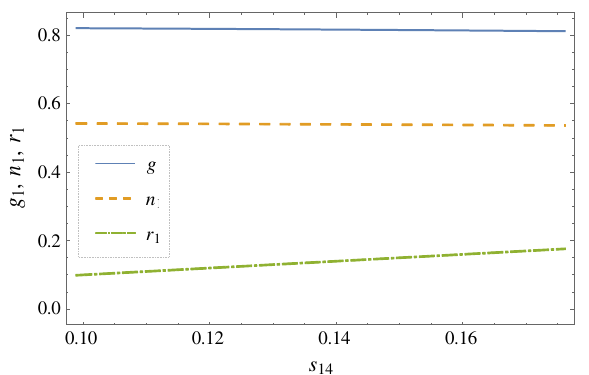
Fig. 3 g 1 , n 1 and r 1 versus s 14 with s 14 ∈ ( 0 . 099 , 0 . 176 )